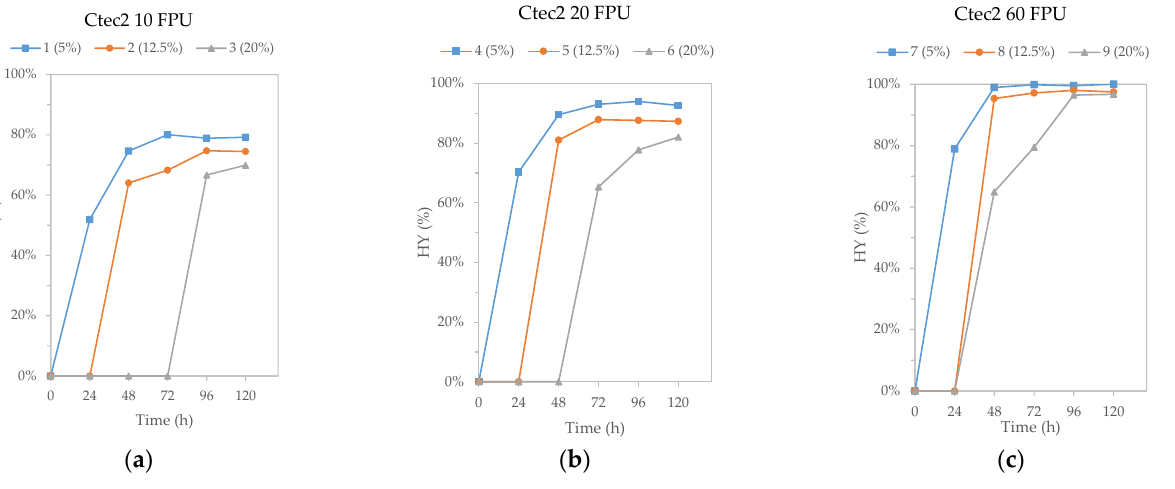
Figure 2. Enzymatic hydrolysis yield (HY) of CSopt saccharification using different solid loadings (5%, 12.5%, and 20% w / w ) at low cellulase (Ctec2) loading (10 FPU/g cellulose, ( a )), medium cellulase (Ctec2) loading (20 FPU/g cellulose, ( b )), and high cellulase (Ctec2) loading (60 FPU/g cellulose, ( c )).